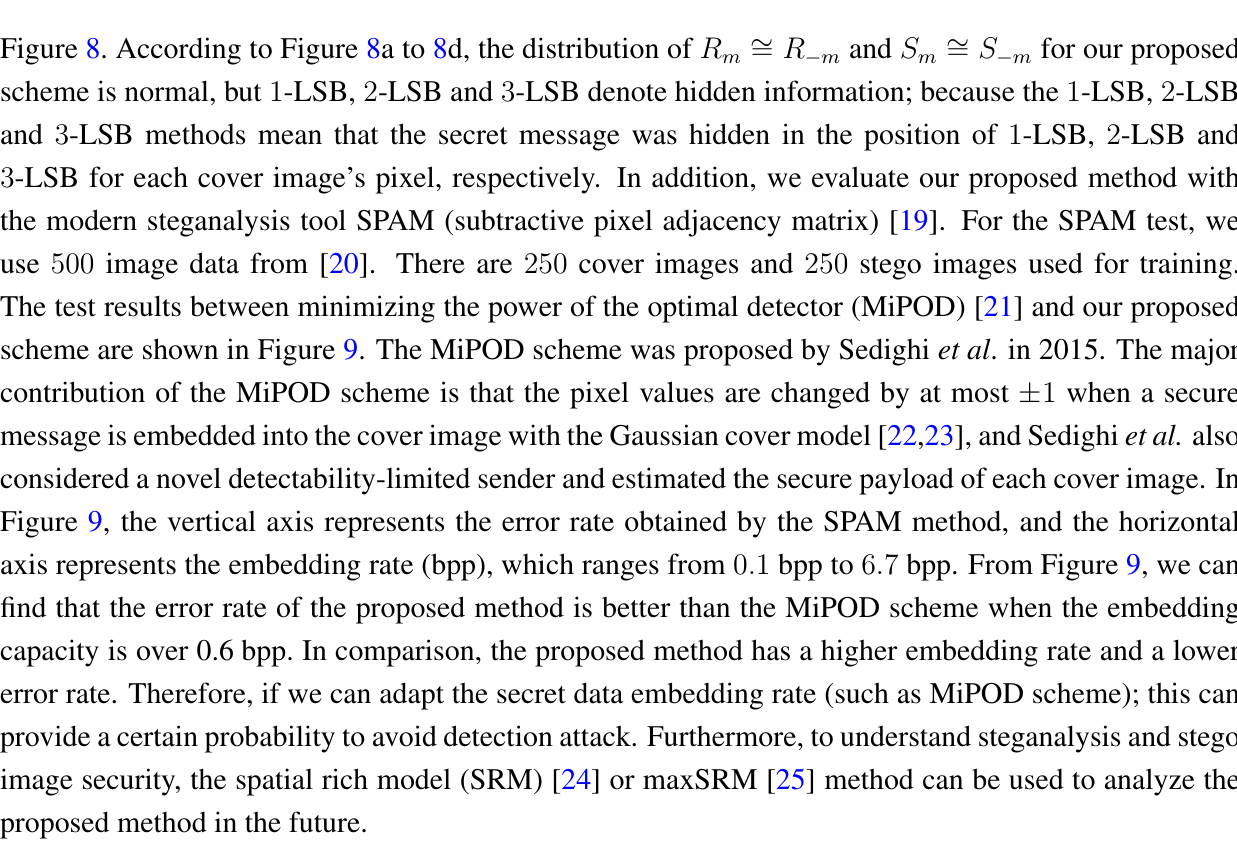
∼ = R ∼ = S and S for our proposed m − m m − m